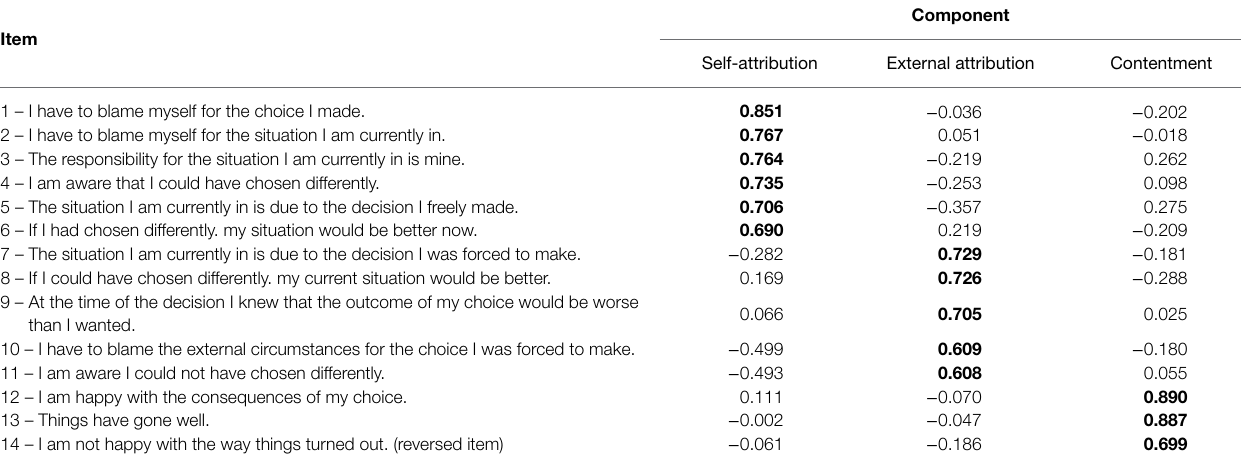
TABLE 2 | Study 1 – rotated component matrix of phenomenology